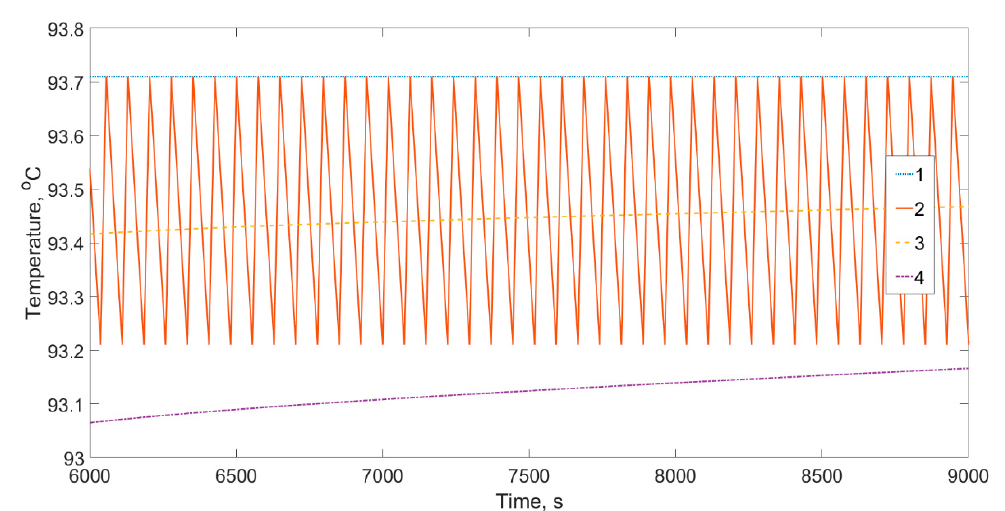
Figure 8. Results of the control simulation for the isolated time interval—no noise: 1—value of the set temperature, 2—output signal of the control system with a relay controller, 3—output signal of the control system with a PID controller and 4—output signal of the control system with an I-PD controller.